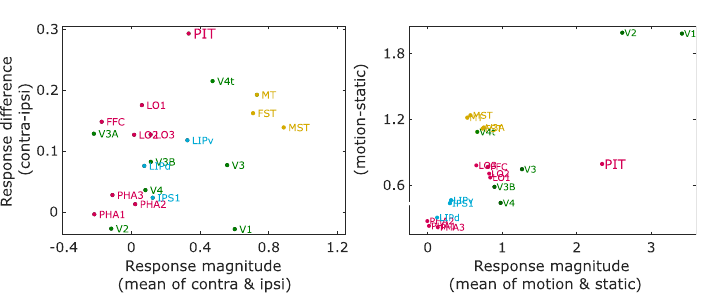
traversal along the posterior – anterior axis of the brain (Fig. 6a, yellow streamlines). Furthermore, this tract is situated along the medio-lateral axis similarly to the VOF, but differs in its anterior – posterior positioning as it connects to the parietal lobe, whereas the VOF is con fi ned to occipital areas (Fig. 6a, yellow vs. pink streamlines; see also Fig. S7). Nearby, both the pArc and the